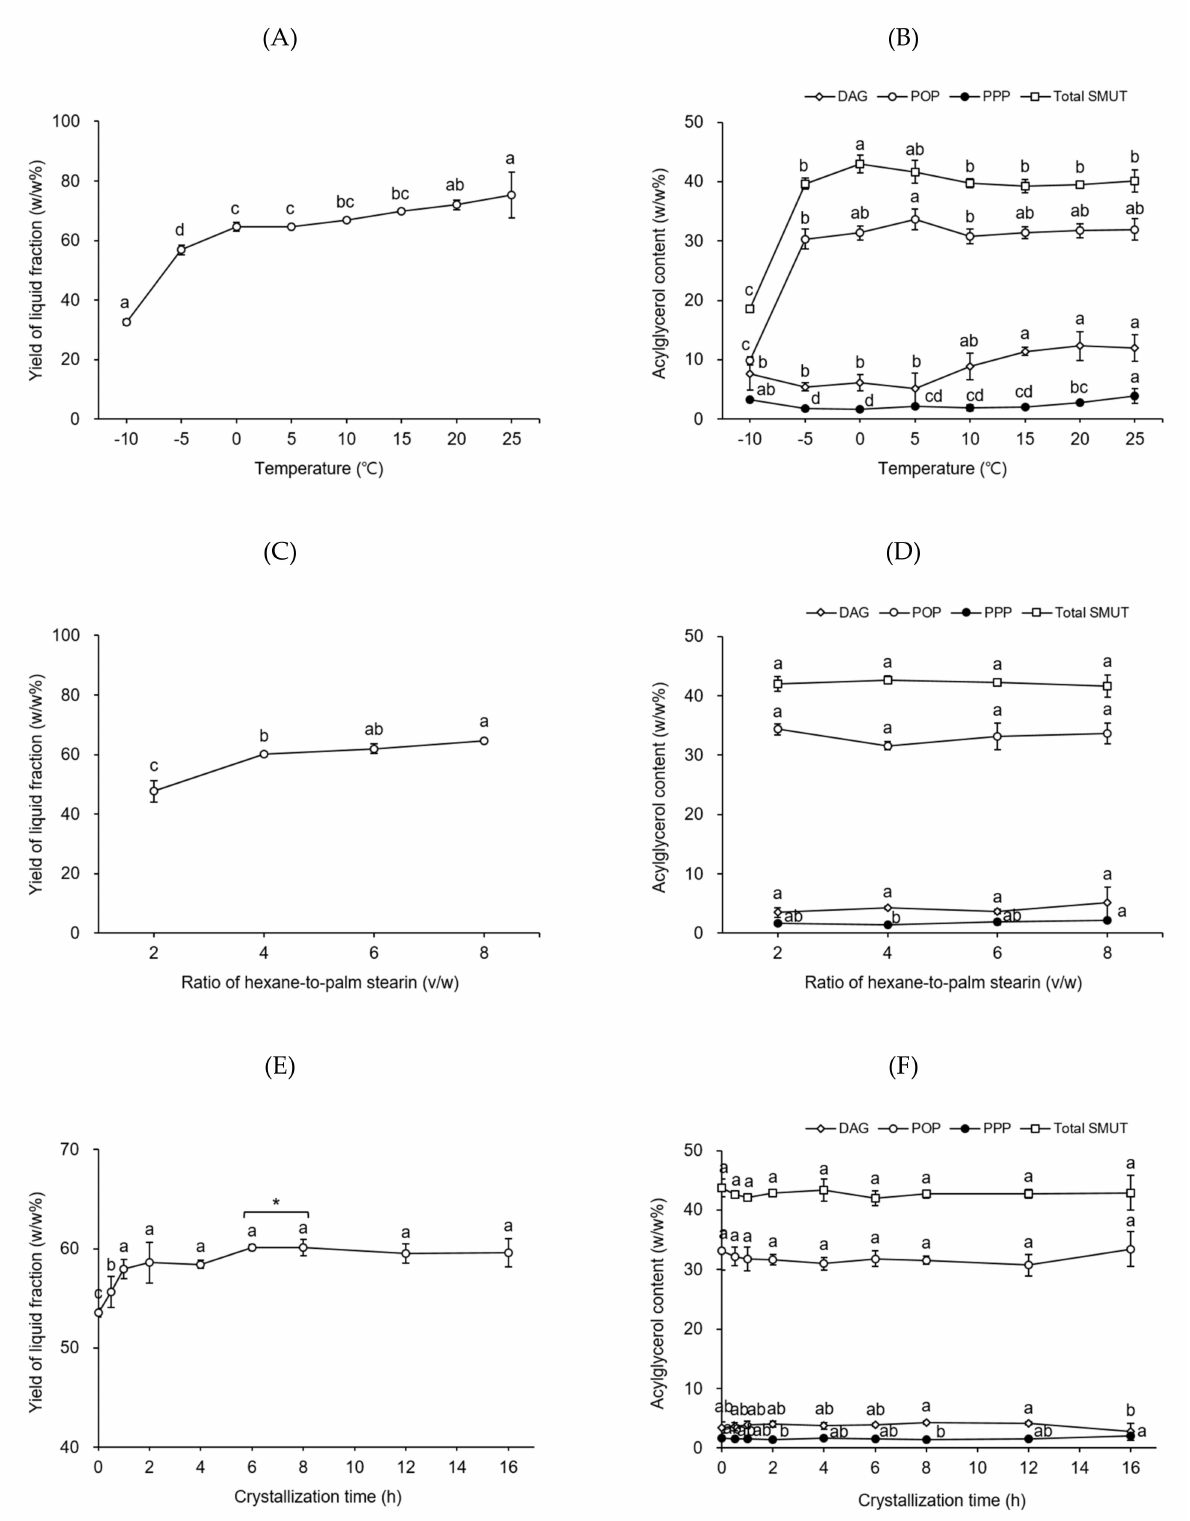
Figure 1. Yield of the liquid fraction ( A , C , E ) and the contents of diacylglycerols (DAGs), tripalmitin (PPP), 1,3-dipalmitoyl- 2-oleoyl glycerol (POP), and total symmetric monounsaturated triacylglycerols (SMUTs) in the liquid fraction ( B , D , F ) obtained from palm stearin during the first hexane fractionation step as a function of temperature, volume-to-weight ratio of hexane-to-palm stearin, and crystallization time, respectively. Fractionation was performed, using 5 g palm stearin in a flat-bottom glass vessel (8 cm × 3.5 cm i.d.). Different letters (a–e) indicate significant differences between samples ( p < 0.05). Asterisk (*) denotes significant differences (determined by a two-tailed Student’s t -test) between the two samples ( p <